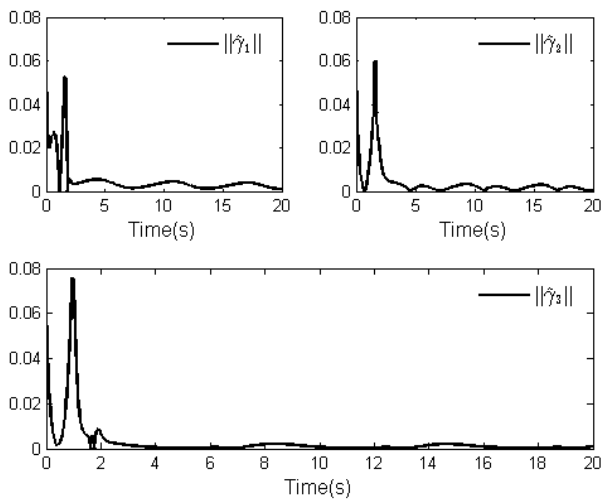
Figure 12. Norms of adaptive laws